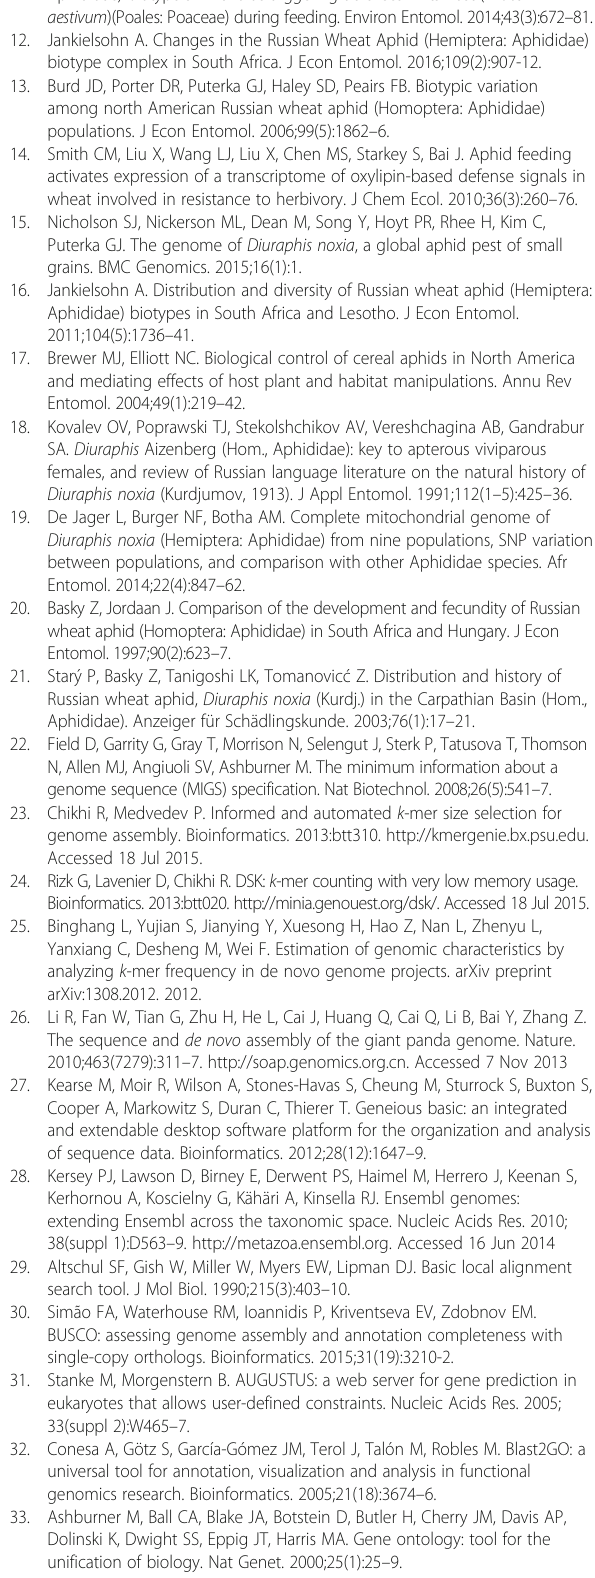
Additional file 1: Figure S1. Comparison of amino acid profiles obtained from protein coding genes in A. pisum (Acyr 2.1) and the levels of amino acids in pea phloem [58]. (JPEG 59